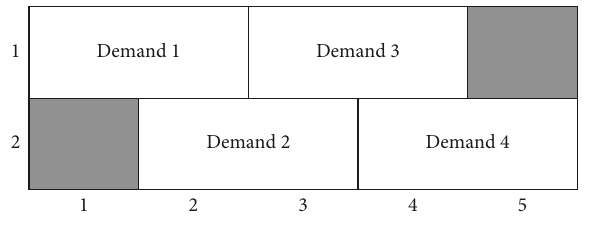
Figure 4: The impact of service order on the use of lot